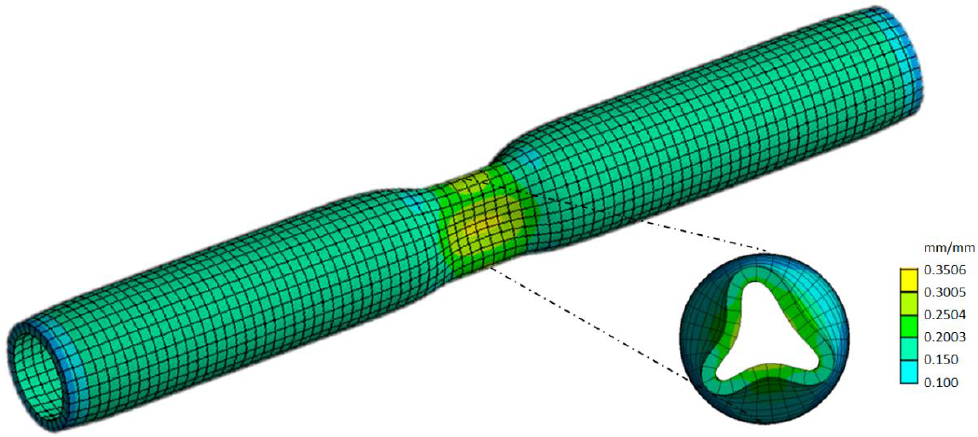
Figure 6. Exemplary representation of the strain regime in the aortic model, featuring a cross-sectional cut through the folding centre plane.